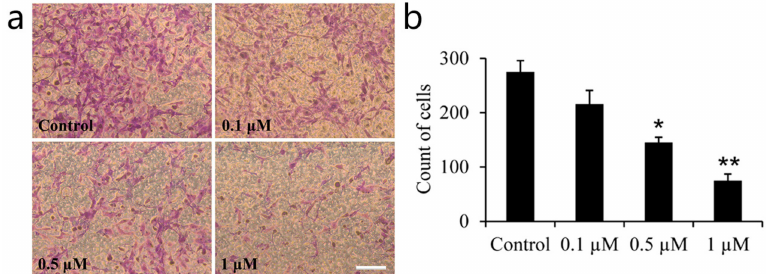
Figure 3. The effect of different concentrations of icariin on cell migration of OA–FLSs for 12 h. ( a ) Cells were treated with 0.1, 0.5 and 1 µ M of Icariin.The migrated cellst were stained with crystal violet. ( b ) Statistical analysis of the cell count for the migrated cells. Statistical difference when compared to the control (* p < 0.05), significant difference when compared to the control (** p < 0.01) (mean ± SD, n = 5). Scale bar: 100 µ